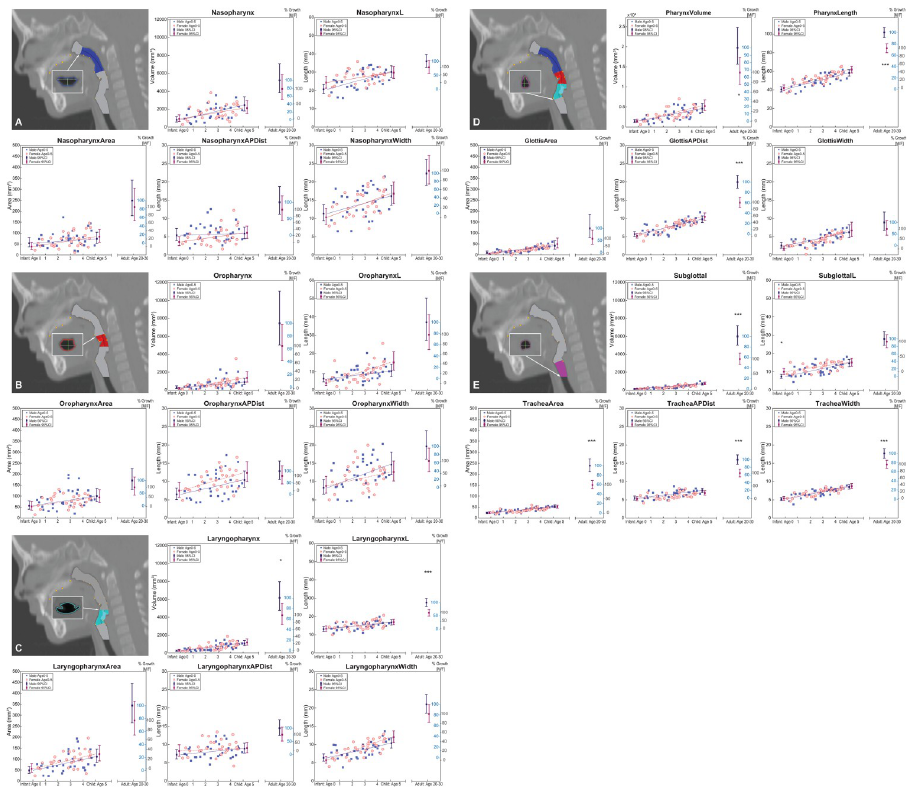
Fig 3. Measurements extracted for pharyngeal region (3A. Nasopharynx; 3B. Oropharynx; 3C. Laryngopharynx; 3D. Pharynx; and 3E. Subglottal). Measurements extracted for each pharyngeal region (3A to 3E) is depicted in top panel image on left, with measurements as defined in Table 5 and consisting of: Top panel; the orthogonal volume, and the curvilinear/centerline volume-length. Bottom panel; the orthogonal cross-sectional area (CSA) (superior 3A, or inferior 3B–3E), its anterior-posterior distance (APDist), and lateral width (Width). Plots include measurements for male in blue filled square symbols, and for female in red shaded circle symbols. Pediatric data include linear fits for males (blue solid line) and females (red dashed line). Point estimate of modeled means and confidence intervals are plotted for adult data, and at ages 0 and 5 years respectively for males (purple) and female (magenta). The second Y- axis reflects the percent growth for males (blue, inwards tick orientation) and females (black, outwards tick orientation). Significance for sex differences at birth, age 5 years and/or adults are denoted with single, double, and triple asterisk(s) at the interval plots using the nominal α < 0.05, < 0.01, and < 0.001 levels respectively; the numeric p values are displayed in Table